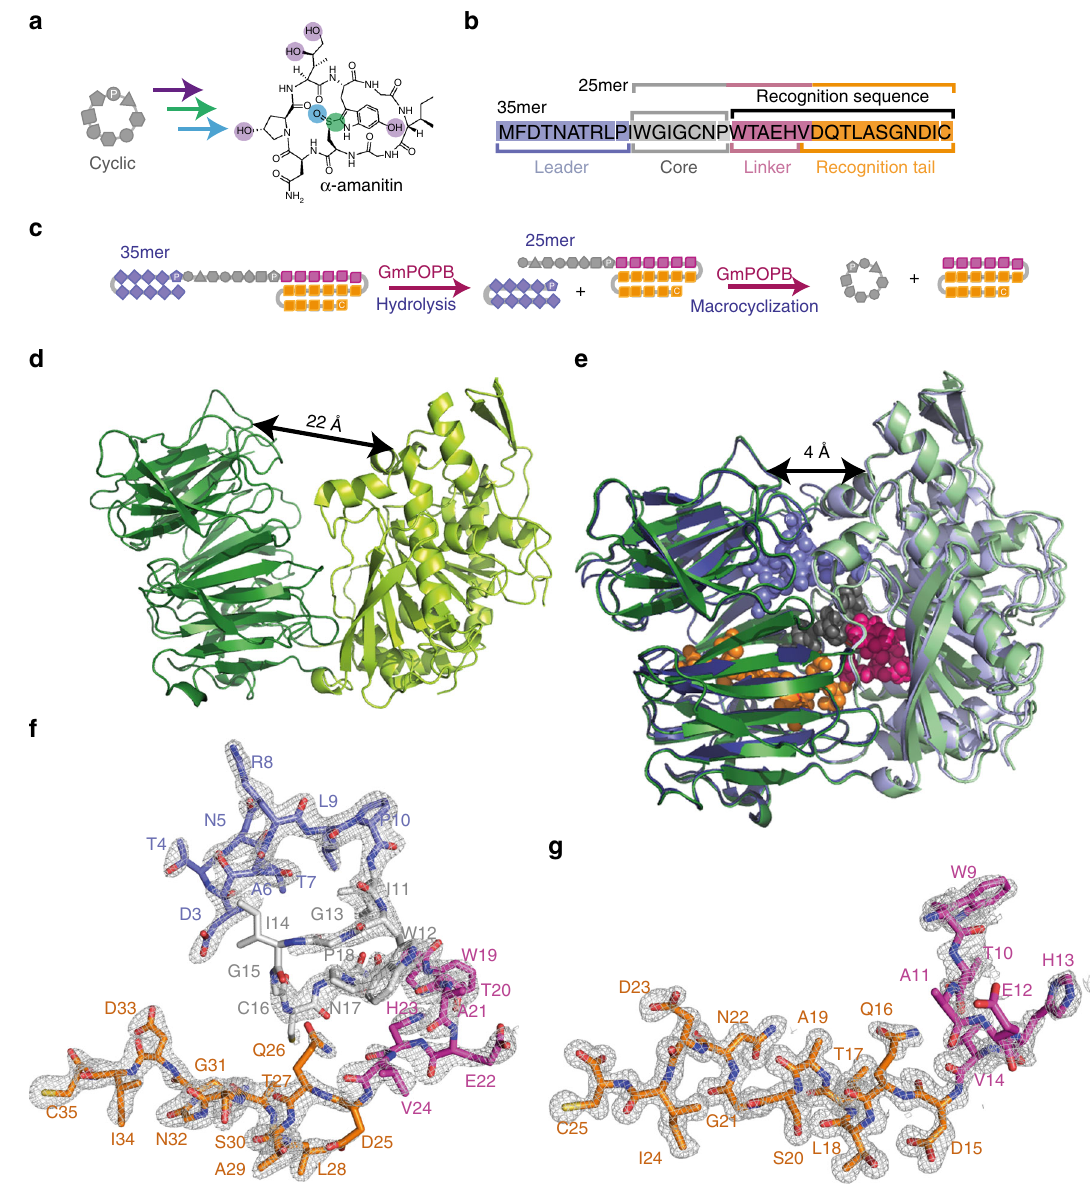
Fig. 1 Amanitin biosynthesis and the role of GmPOPB. a Biosynthesis of α -amanitin from the cyclic peptide produced by GmPOPB involves oxidation ( blue circle ), hydroxylations ( purple circles ), and cross linking ( green circle ). Amino acids in the cyclic peptide are depicted as geometrical shapes, and the core proline is labeled. b 35mer substrate used by GmPOPB to catalyze peptide bond hydrolysis and macrocyclization. Peptide is divided in four regions, leader ( blue ), core ( light gray ), linker ( magenta ), and tail ( orange ). The color coding for peptide regions for c , e – g follows this. c Scheme of the reactions catalyzed by GmPOPB. d ApoGmPOPB in an open state showing 22 Å separation between the β -propeller ( dark green ) and the peptidase domain ( light green ). e Overlay of 25mer ( blue ) and 35mer ( green ) complexes of S577A. Separation between domains is reduced to 4 Å when peptide is bound. 35mer peptide is shown in spheres . Darker colors show the β -propeller domain, while light colors show the peptidase domain. f 35mer peptide bound to GmPOPB-S577A showing electron density (2 F o — F c contoured at 1 σ level in gray mesh ) for peptide. g 25mer peptide bound to GmPOPB-S577A showing electron density for peptide (2 F o — F c contoured at 1 σ level in gray mesh ). Supplementary Fig. 11 contains a stereo image depicting electron density maps for the 25mer